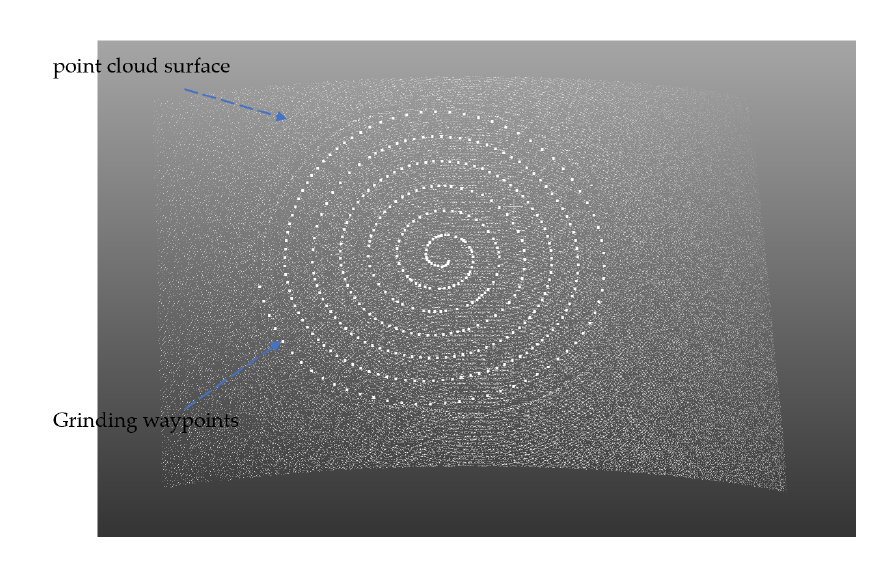
Figure 13. Radial line graph on the point cloud curve surface.